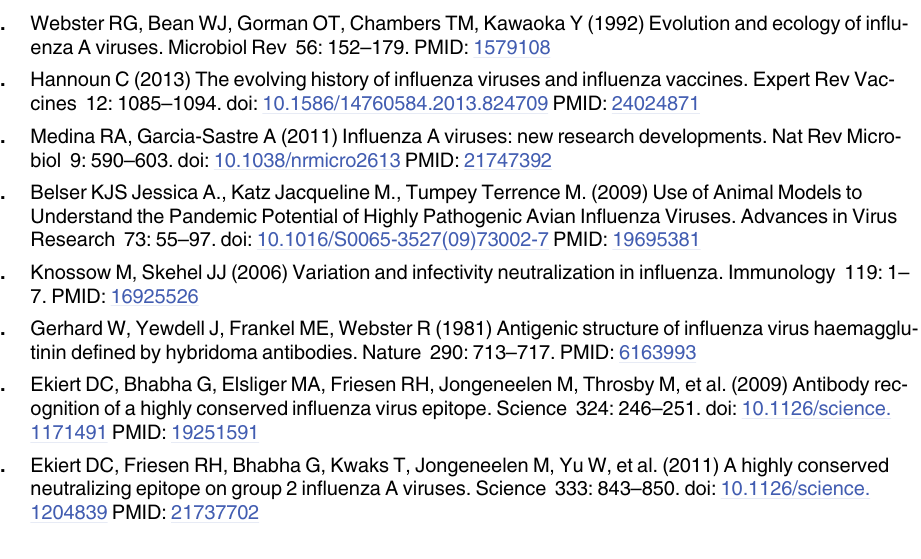
S3 Fig. Pre-challenge antibody responses were comparable between different groups. Mice (n = 8-12/group) were immunized once with TVV+MM or PBS as negative control 4 weeks before challenge. (A) CD8 + or the combination of CD4 + and CD8 + T cells or (B) CD4 + T cells were depleted with depleting antibodies or matching isotype control injections 4 days and 1 day before challenge. At the day of challenge plasma samples were isolated to determine H1-specific (recHA of A/California/07/09) antibody responses. Black bars indicate medians of log-10 transformed ELISA titers (EU). S1 Table. Summarizes p-values of various group comparisons of antibody responses. Statis- tical analysis was performed as described in the material and methods section.